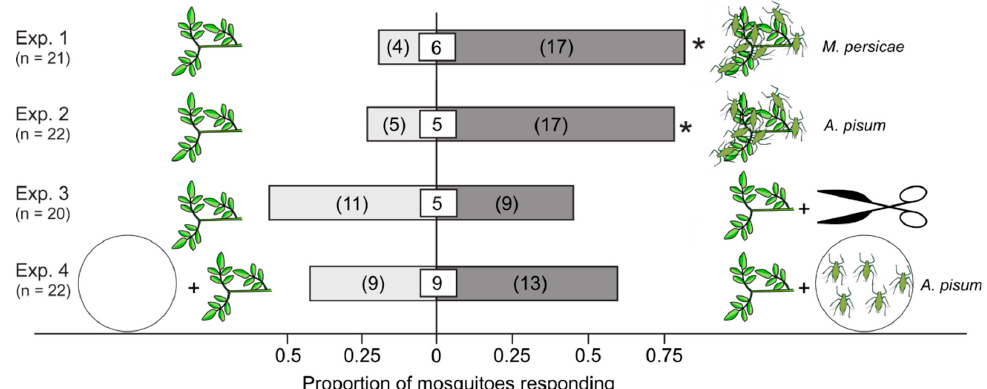
Figure 1. Proportion of female yellow fever mosquitoes, Aedes aegypti , responding in binary choice Y-tube olfactometer experiments (N = 20–22 replicates) to fava bean plants, Vicia faba , that were non-infested (control) or that were ( i ) infested with green peach aphids, Myzus persicae (Exp. 1), or pea aphids, Acyrthosiphon pisum (Exp. 2); ( ii ) mechanically injured (Exp. 3), or ( iii ) paired with 100 non-feeding pea aphids. Numbers in parentheses represent the number of mosquitoes selecting a test stimulus, and numbers in square boxes in bars represent the number of non-responding mosquitoes. For each experiment, an asterisk (*) indicates a significant preference for a test stimulus ( p < 0.05; exact test of